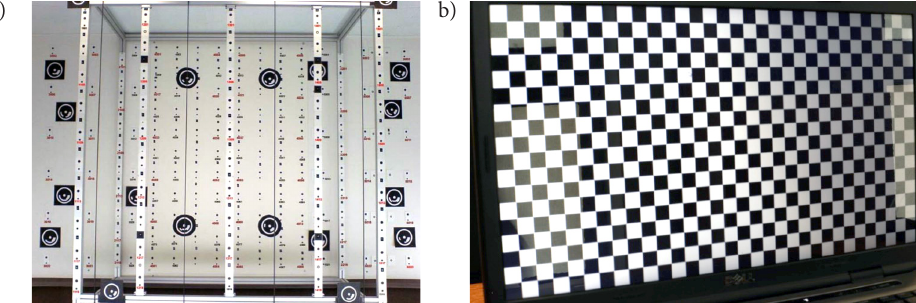
Figure 1. An example of the test fields used for the calibration of non-metric measurement cameras: a – a spatial test field at the Federal University of Technology in Zurich; b – a flat checkerboard test field in the Agisoft Lens software (source: Tokarczyk, 2022)